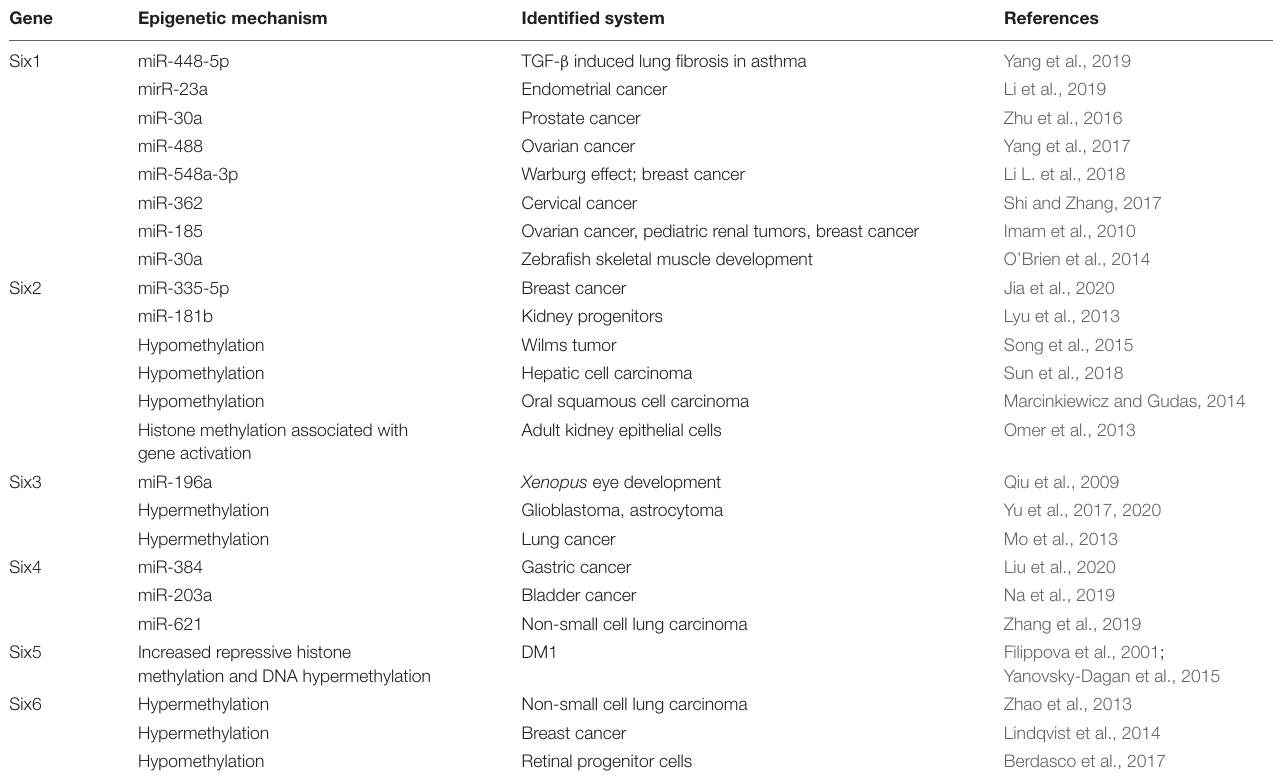
TABLE 4 | Epigenetic regulation of SIX transcription factor